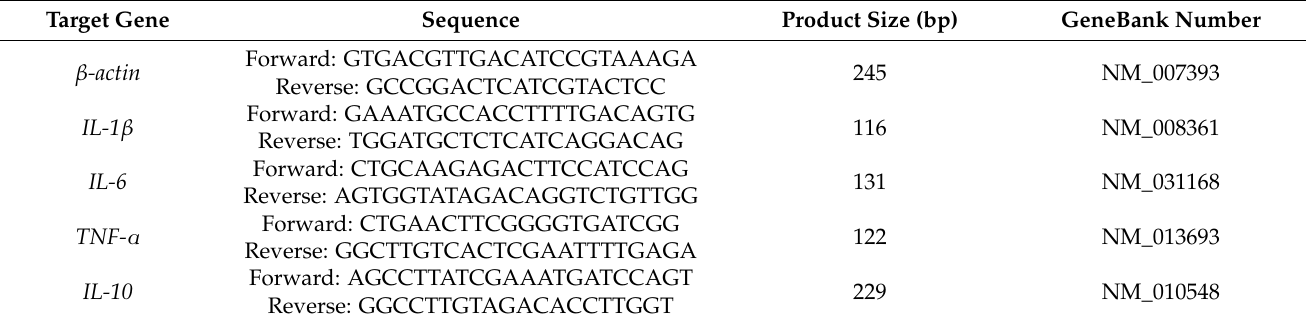
Table 1. Primer sequences for each target inflammatory